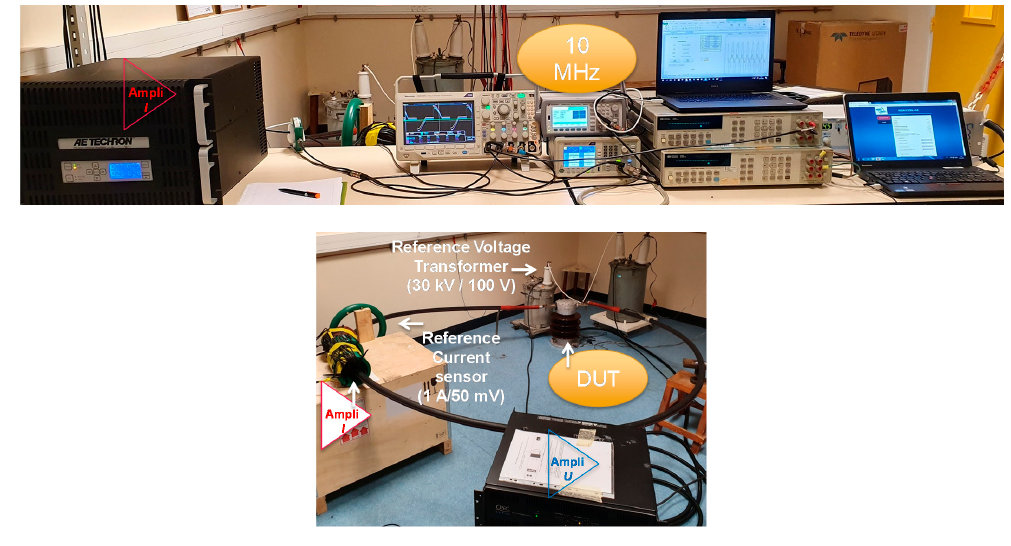
Figure 2. EMS calibration setup at LNE.